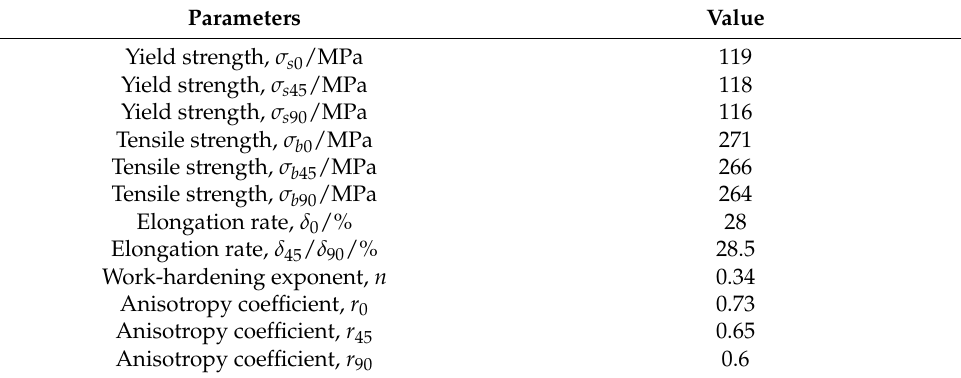
Figure 2. Geometry of tensile specimen. Table 1. Mechanical properties of aluminum alloy 5182-O.